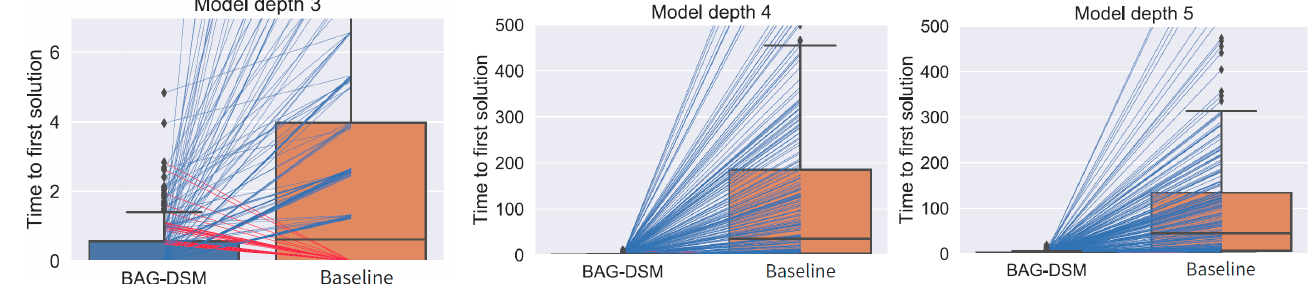
Figure 12. Paired boxplots for the time (shorter is better) required to find the first optimal alternative by BAG-DSM vs. baseline for decision support models with a depth of 3, 4, and 5. The horizontal lines connect two experimental runs with the same experimental setup. The red lines represent the experimental setups in which the baseline performed better.